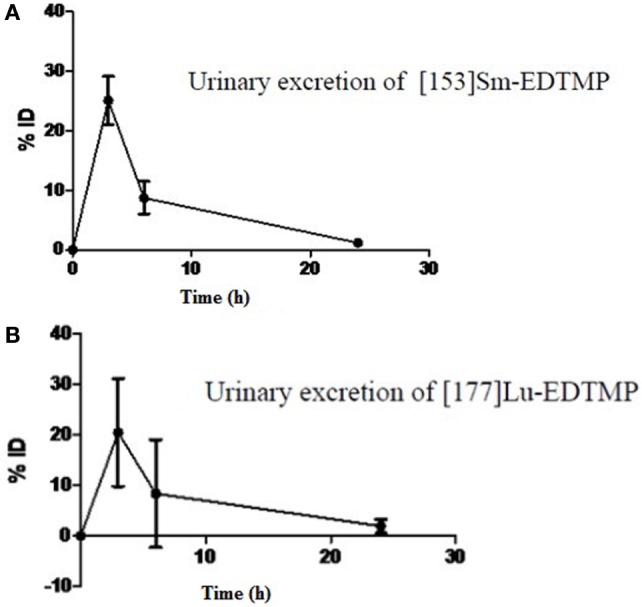
Urinary excretion pattern of (A) 153Sm-EDTMP (B) 177Lu-EDTMP.